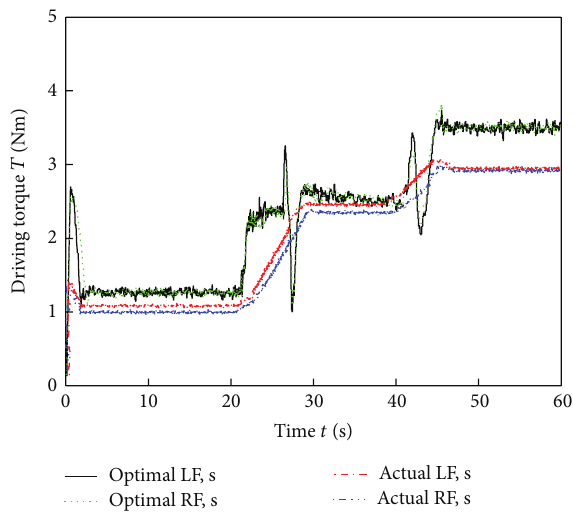
Figure 16: Power consumption comparison of different control